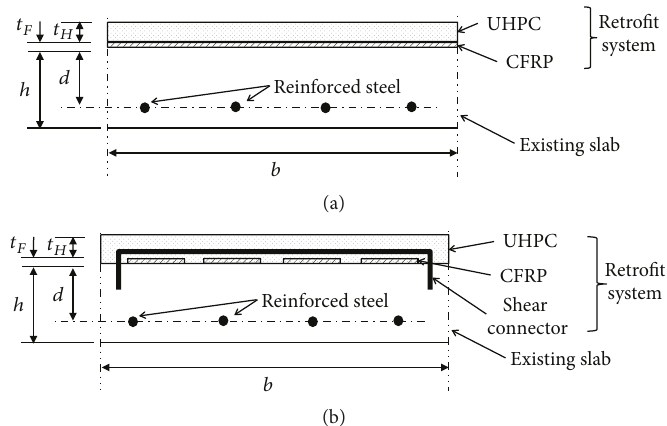
Figure 1: HPC-CFRP retrofit systems for flexural strengthening of the positive moment sections of RC slabs, (a) previously proposed system and (b) the modified system including shear